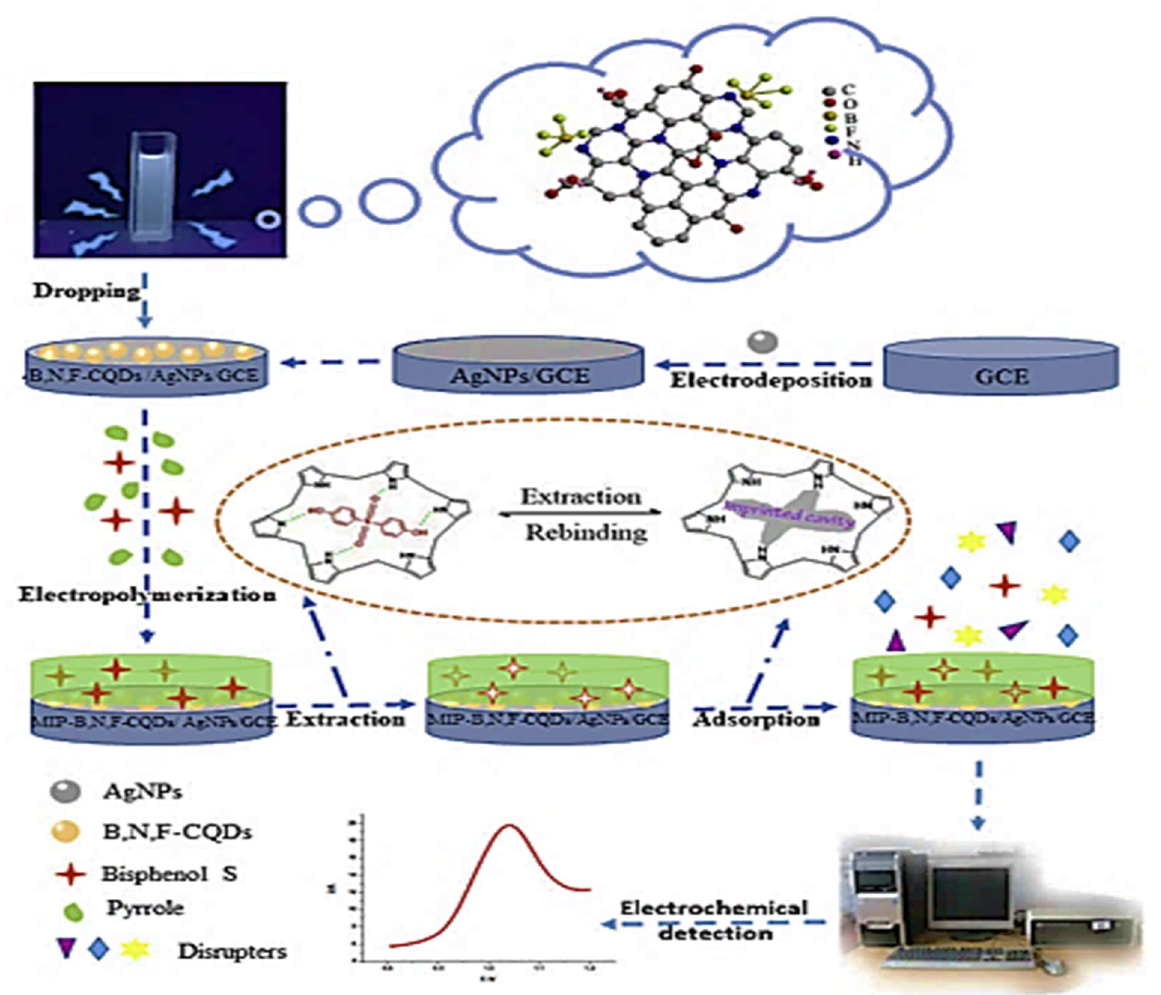
Figure 10. A schematic illustration of the composite of three-doped carbon quantum dots (B, N, F-CQDs) and silver nanoparticles (AgNPs) modified glassy carbon electrode (GCE) for the detection of Bisphenol S [148]. (Reproduced under permission from Elsevier, doi:10.1016/j.aca.2019.03.051).